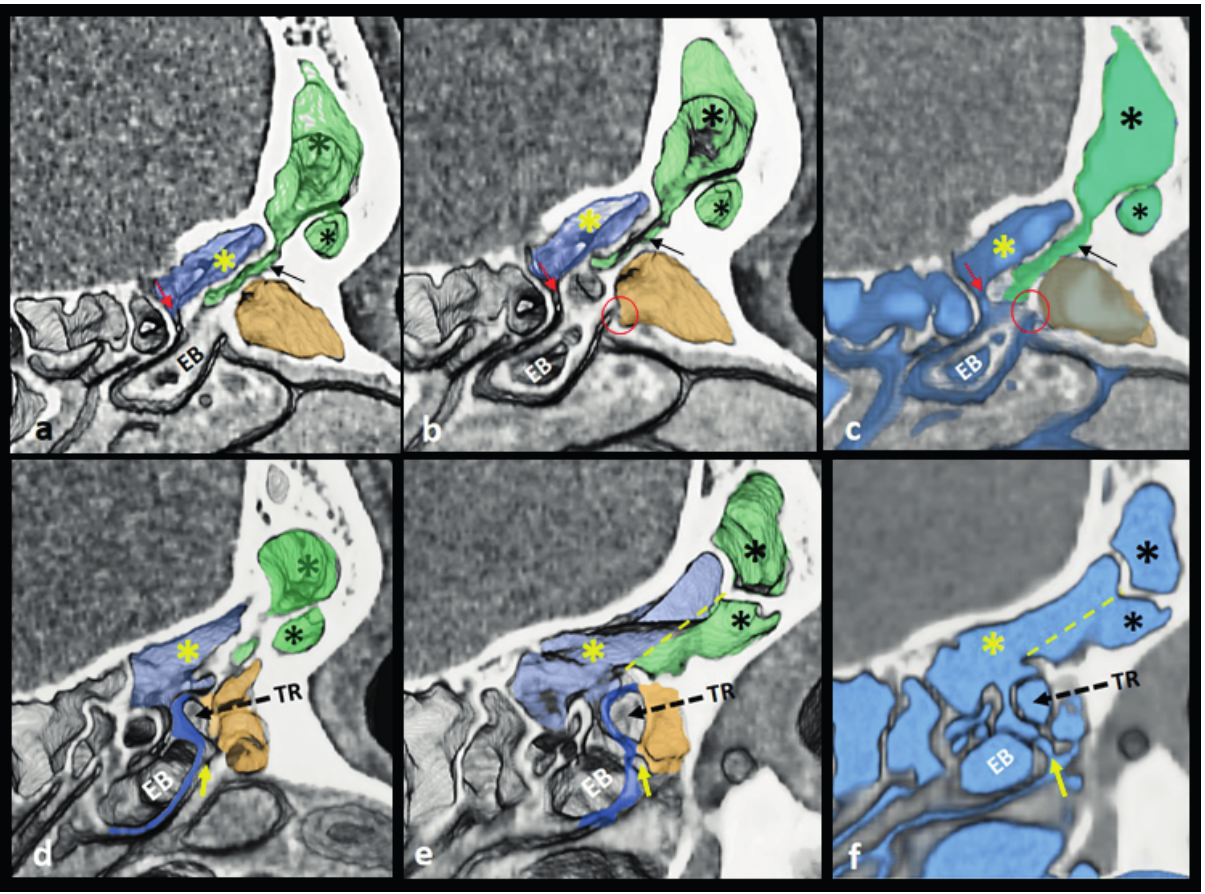
Figure 5. The Fronto-Bullar Space. A. The Supra Bullar Recess Space expands into Frontal Sinus. a.-f. 3D sagittal images (left side) in sequence from medial to lateral, reveal the SBS (yellow asterisk, light blue outline) as it extends supero-anteriorly along the skull base, medially, into the space of the FR, with only a narrow space remaining between the IS-EUP (gold outline) inferiorly, and the SBS superiorly (black arrow). Figs. b and c, show the communication between the IS-EUP (gold outline) and the TI (red circle). The posterior SBS commu- nicates with the RBS (red arrow). Laterally, shown in Figs. d.-f., the SBS is in direct communication with the laterally expanding FS (black asterisks). The plane where the SBS and FSRS merge, is shown by the dashed yellow line. Fig. f. reveals the 3D outline of the airspaces within the anterior ethmoid sinus and the FSRS (dark blue outline). Note, note, the creation of a TRS (TR) between the superior UL (gold outline) and the BL (blue outline), which drains into the EI (yellow